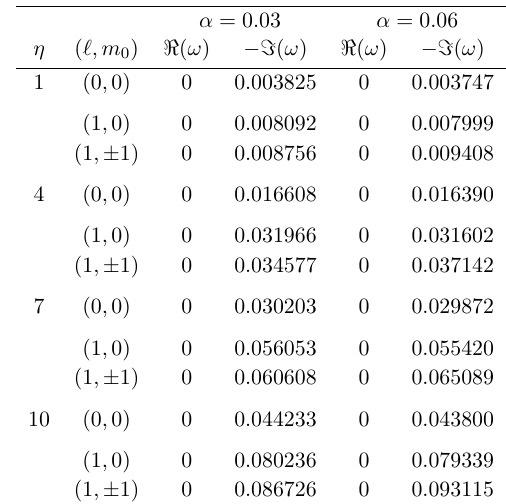
Table 6 . Near-extremal quasinormal modes with 3 r h = − Λ = 3